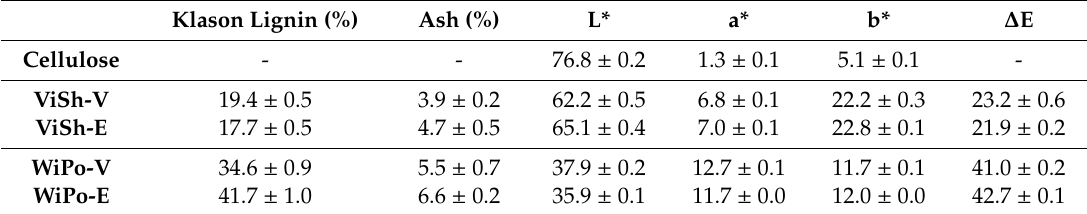
Table 1. Klason lignin and ash content and the color attributes of